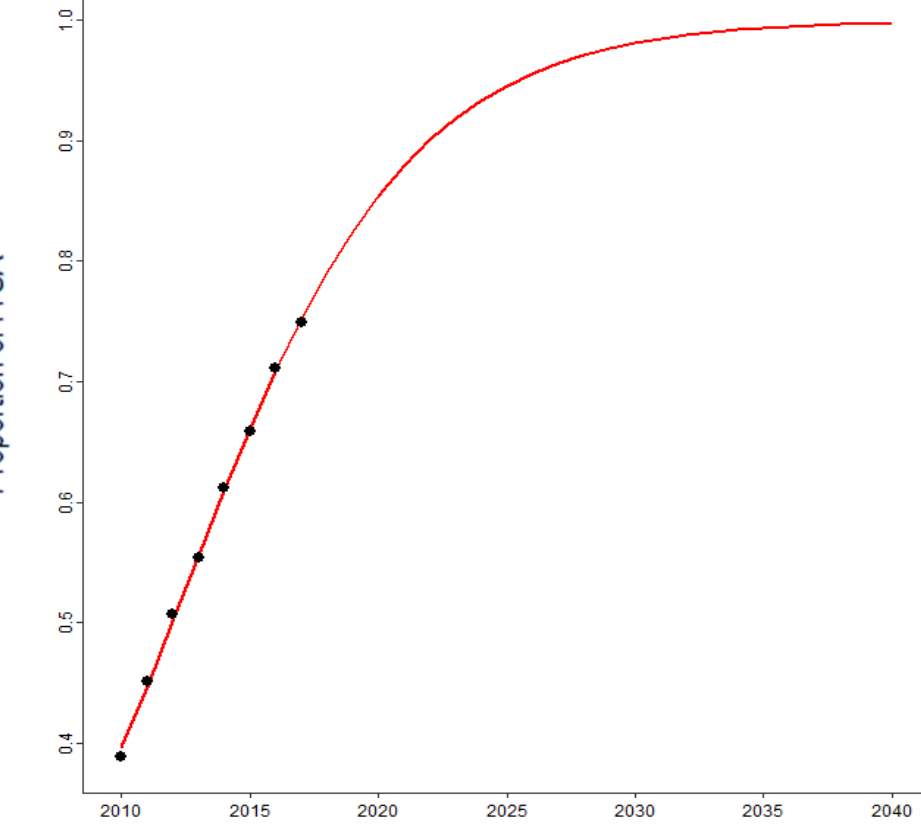
Figure 5. Projected share of reverse total shoulder arthroplasties (rTSA) in total shoulder arthroplasties from 2010 to 2040.